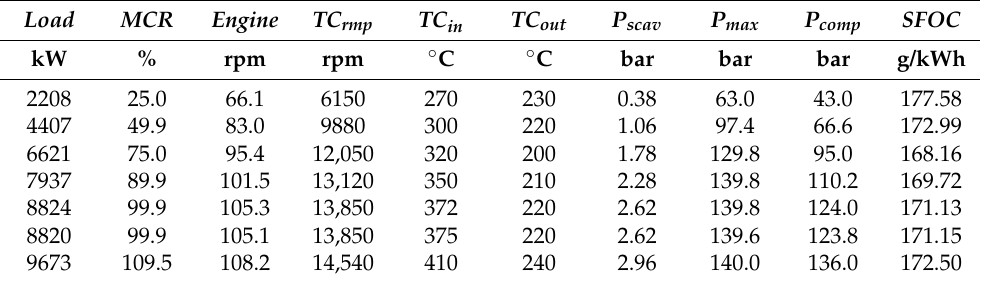
Figure 1. Engine 5S60MC and TCA 66-20072 turbocharger, 1—compressor wheel, 2—turbine rotor, ( a , b )—acoustic measuring points. Table 1. The main engine 5S60MC official test